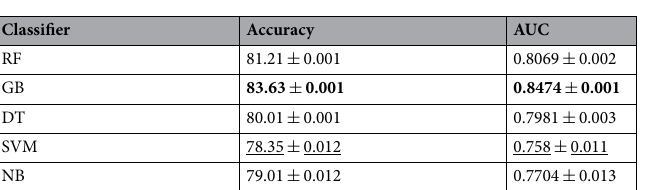
Table 2. Ablation study on the impact of using different numbers of different classifiers in the proposed co-training process on the labeling performance. Bold entry highlights the best-performing technique. Underlined entry highlights the worst performing technique.